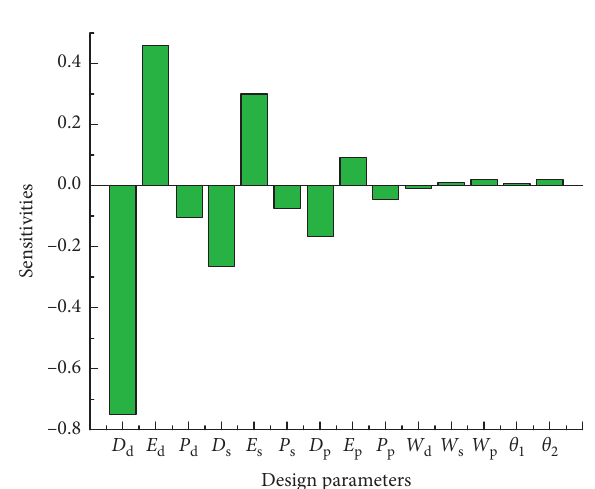
Figure 10: The result of sensitivity analysis.